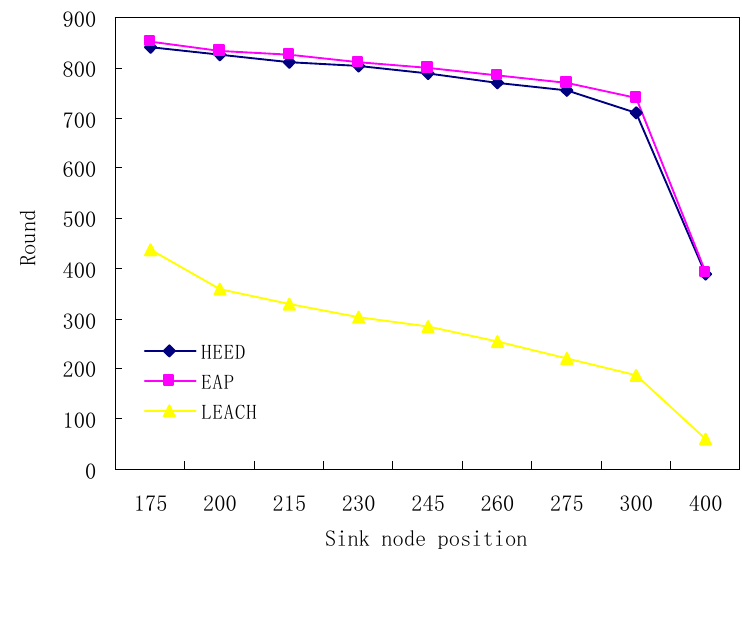
Figure 11. Sink node position vs. network